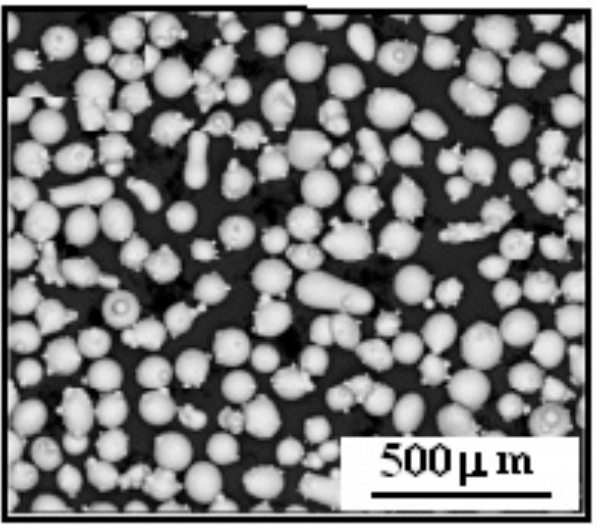
Figure 1. Morphology of Inconel 625 powder.